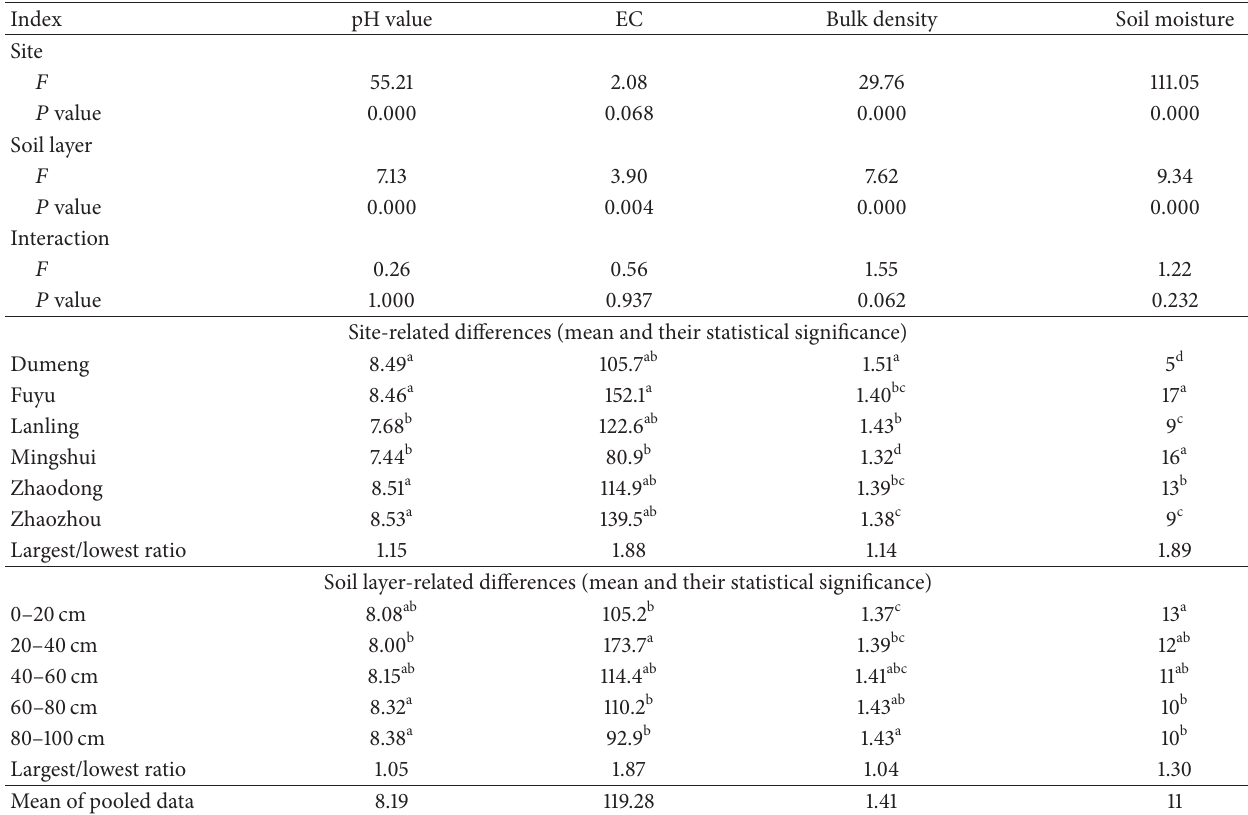
Table 2: Two-way ANOVA results on spatial (site, soil layer) variations of different soil physicochemical properties in poplar shelterbelt forests in Songnen